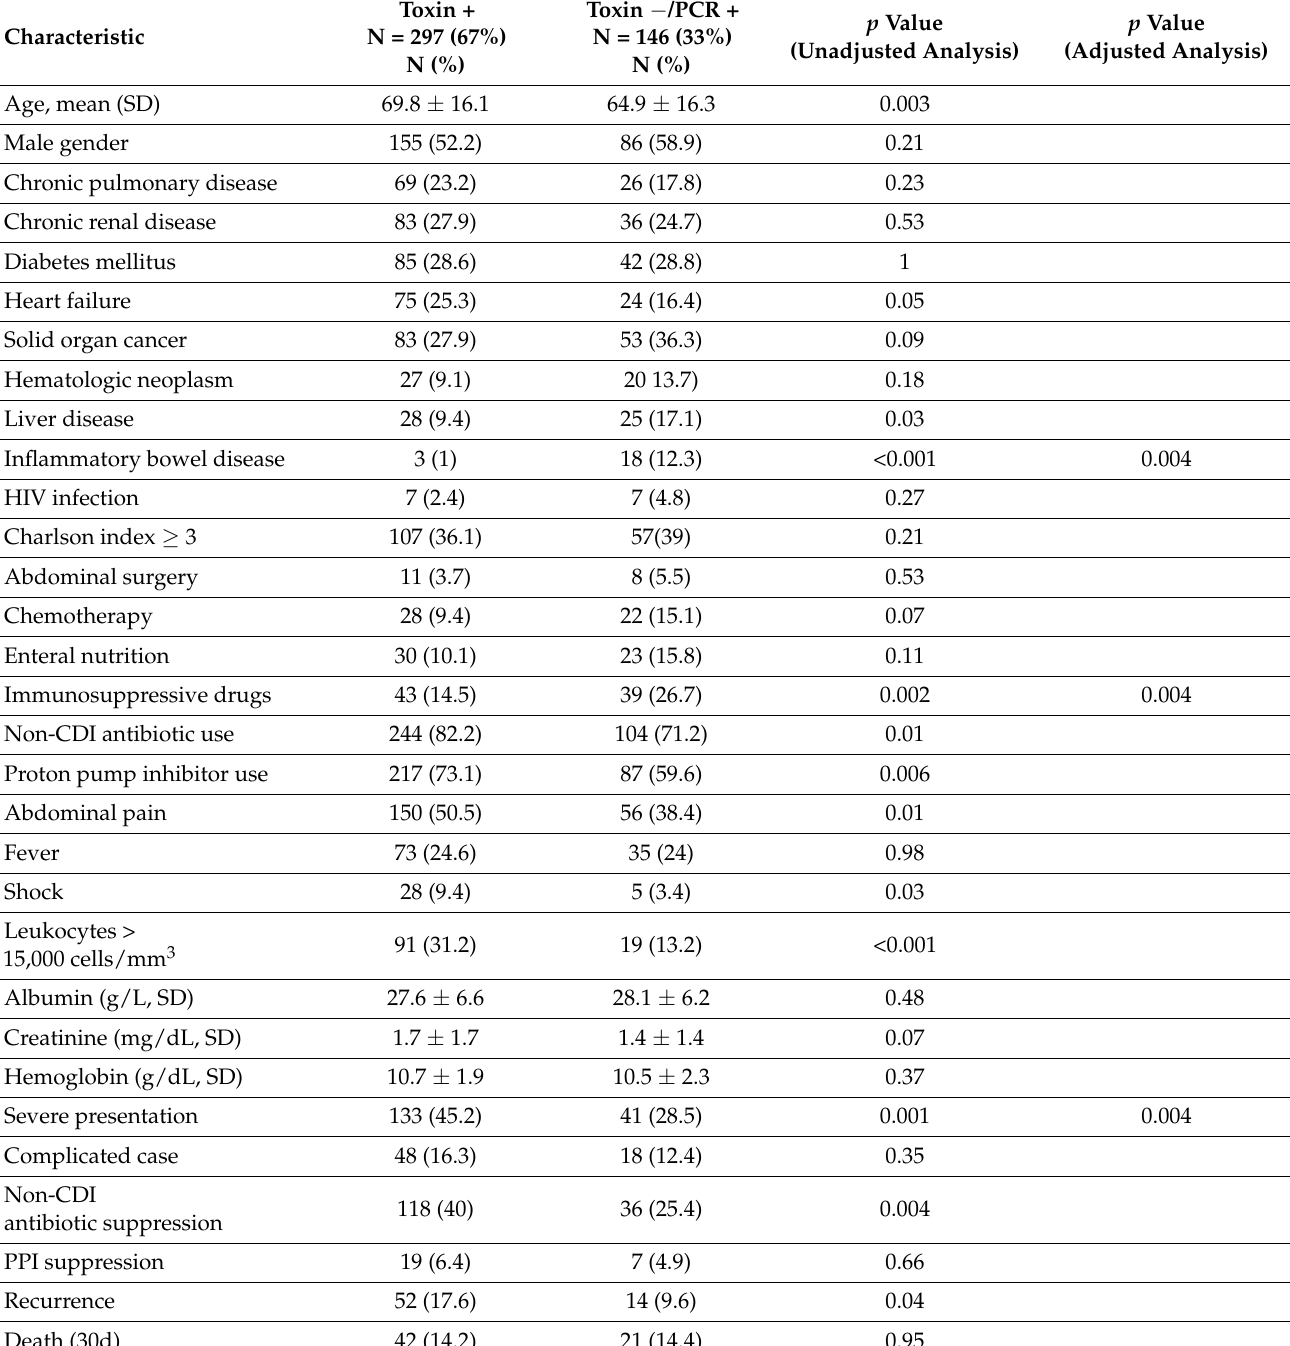
Table 2. Univariate and multivariate predictors of toxin-positive